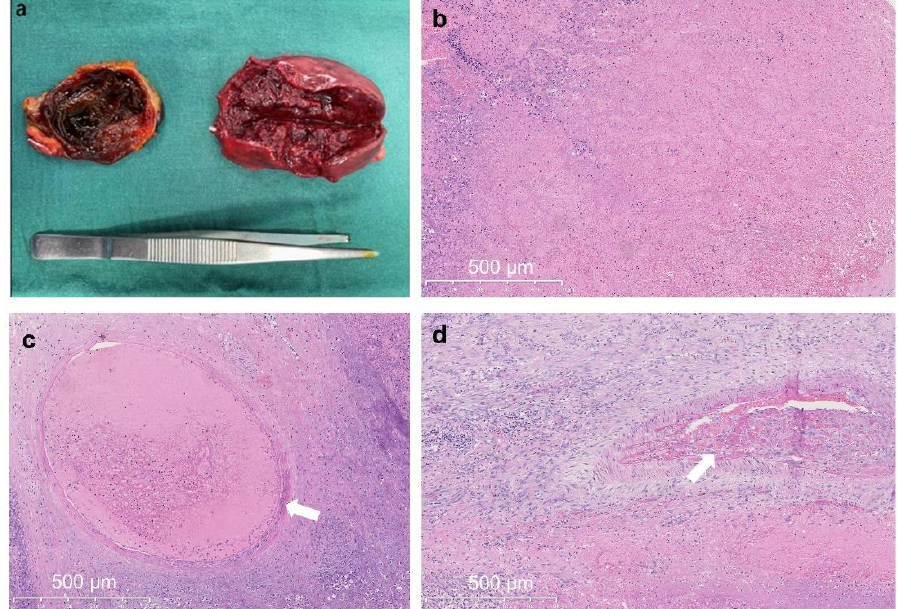
Figure 4. Accessory spleen histological evaluation. Image of the gross specimen ( a ) and pathological examination (HE × 100) ( b – d ). White arrows: thrombus formation ( c ) and thrombus organization ( d ). Scale bar: 500 µ m.